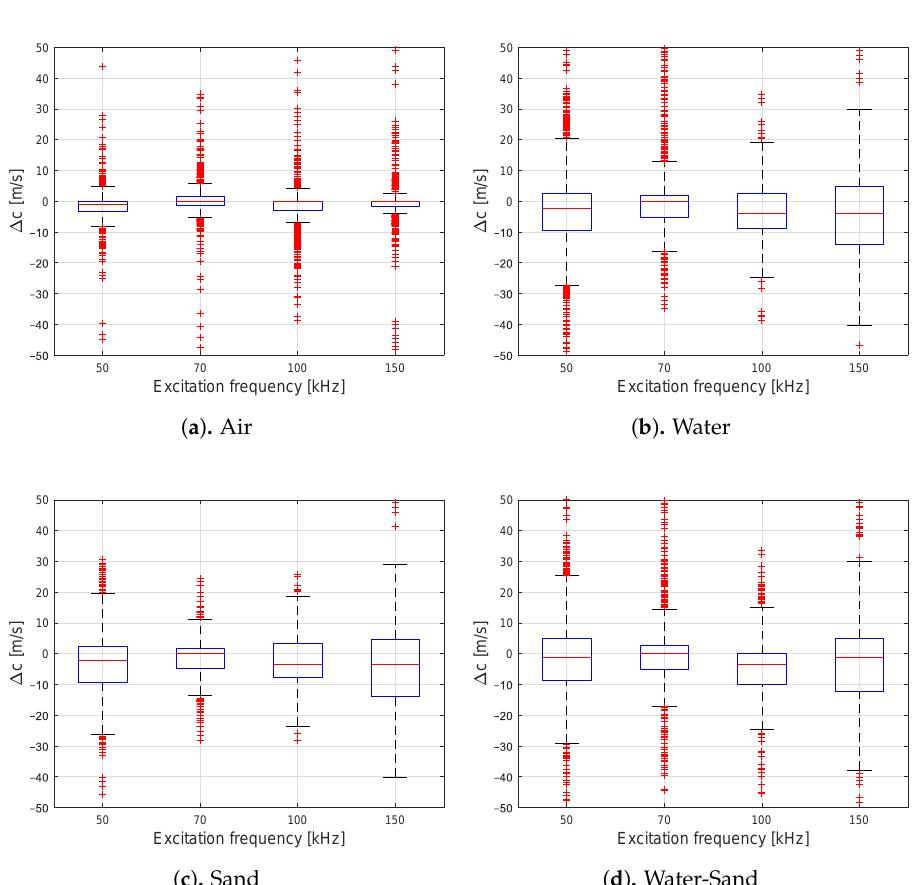
Figure 5. Change of the estimated group velocities ∆ c for all acquired experimental data compared to its reference. The data contains all measured circumferential FA-L(0,1) of ring number two and specified for each excitation frequency separately. Additionally, the data are selected for propagation paths solely along the given phase (air, water or sand) or phase transition